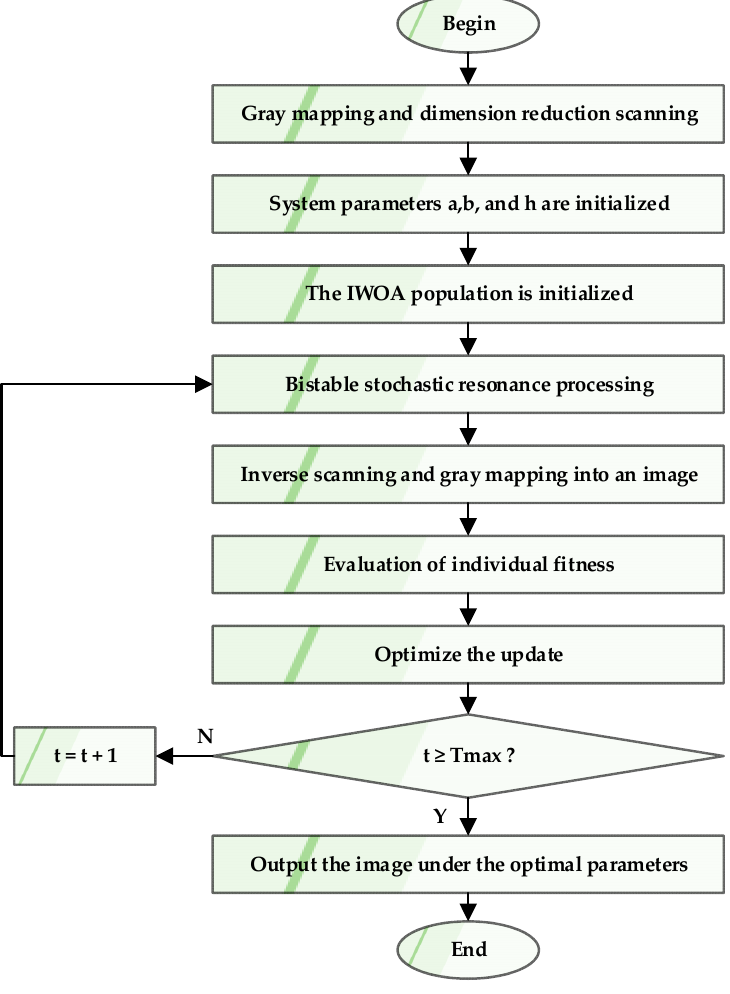
Figure 3. Flow chart of array SR based on